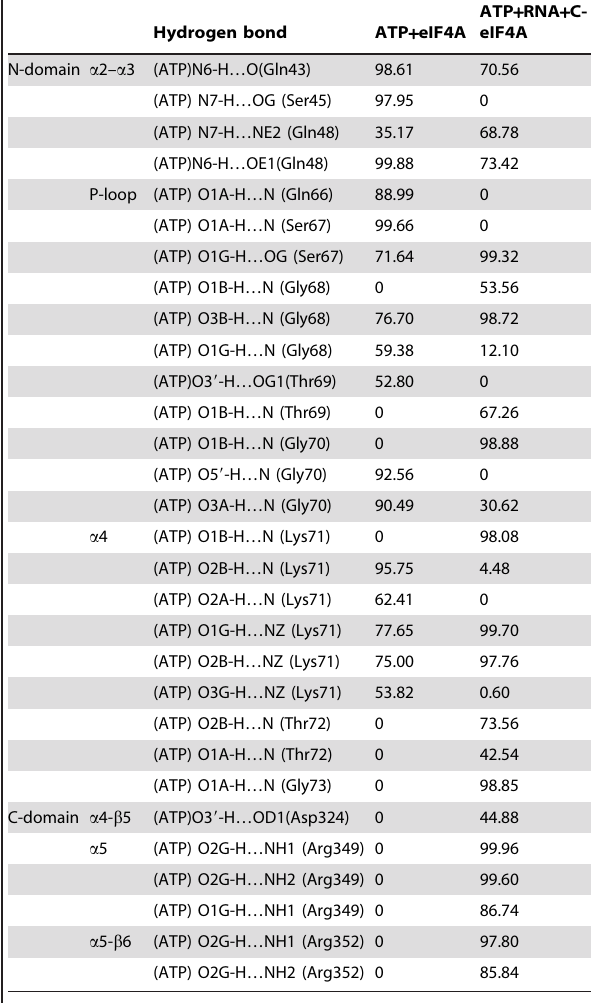
Table 2. The occupancies (%) of hydrogen bonds between the ATP and eIF4A protein for the ATP + eIF4A and ATP + RNA + C-eIF4A